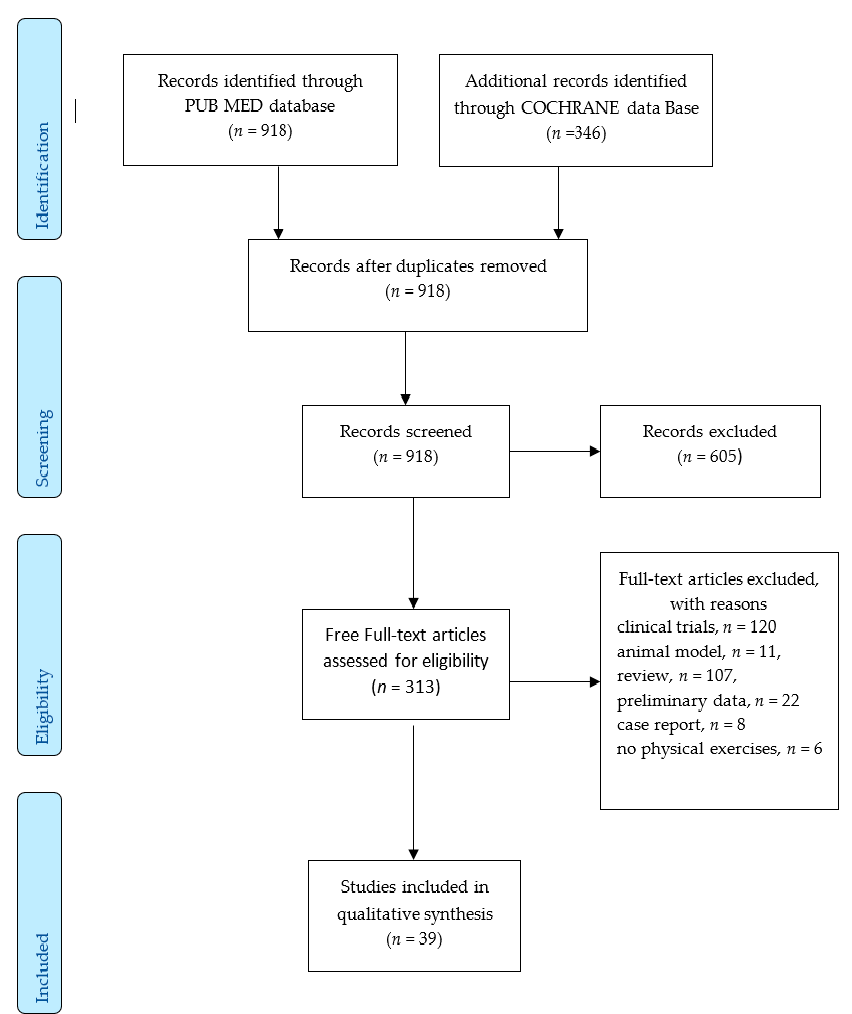
Figure 1. PRISMA diagram.